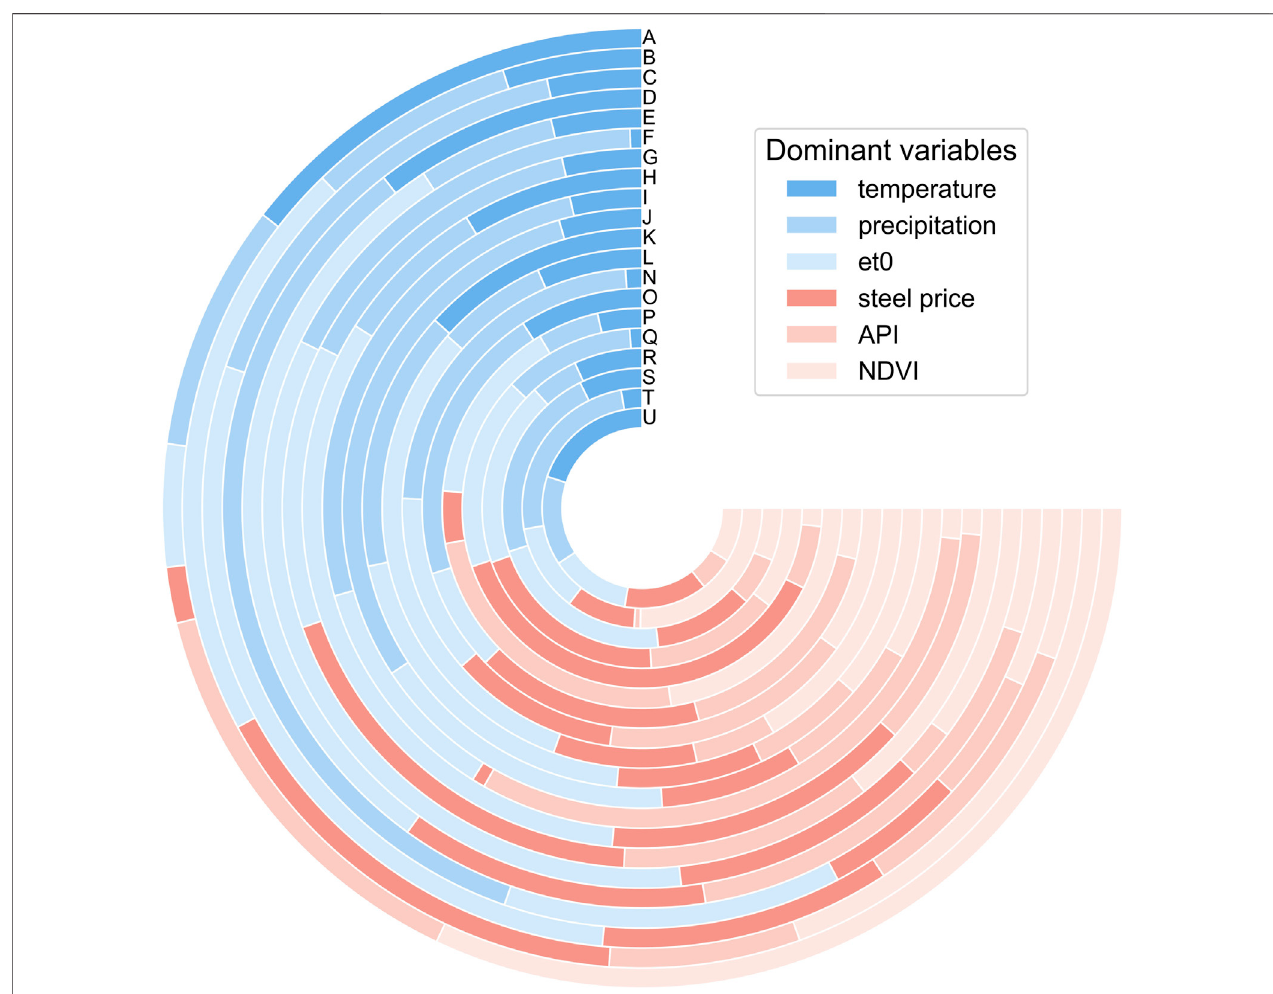
FIGURE 13 | Impact of dominant variables on water table depth at each site.